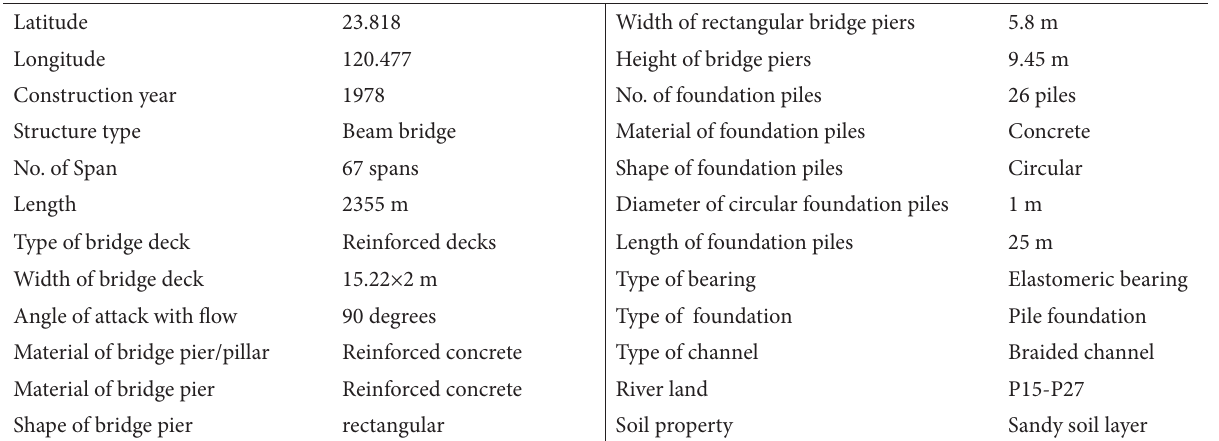
Table 3. Fundamental descriptions of Chung Sha